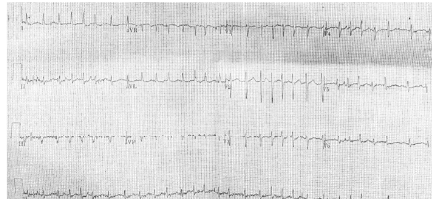
Figure2:ECGinthetelemetryunitdemonstratingtachycardiawith an irregular rhythm with presence of > 3 different p morphologies consistent with multifocal atrial tachycardia